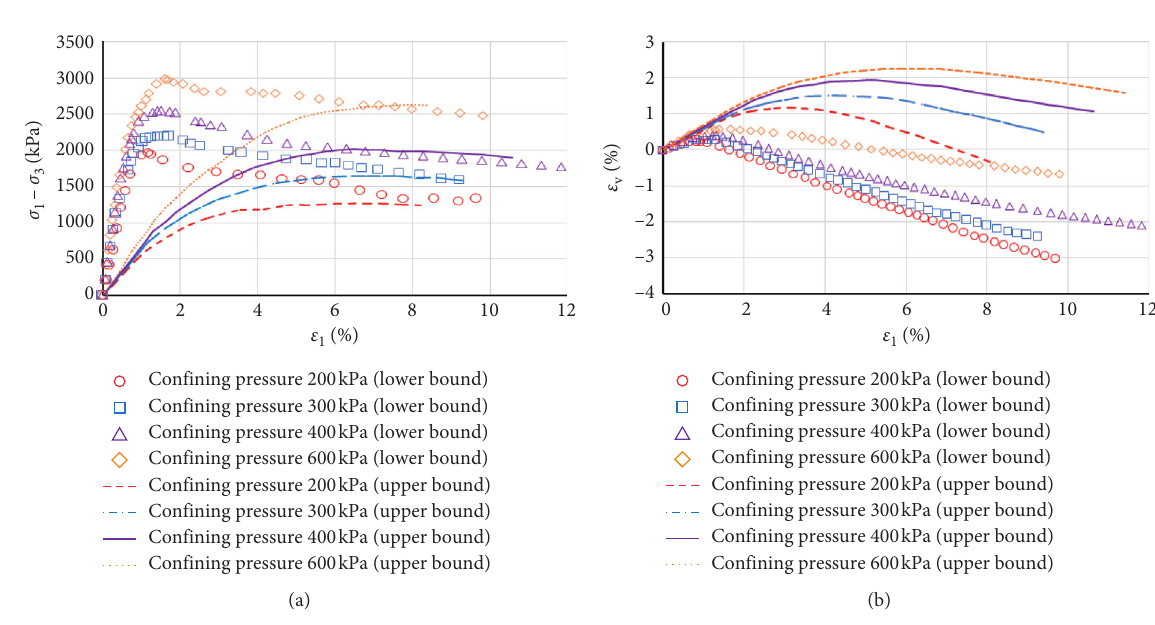
Figure 10: Relationship curves of the deviatoric stress and body strain with the axial strain of rockfill materials with gradation at the upper and lower bound of the gradation envelope after grouting reinforcement. (a) Deviatoric stress for the upper bound and lower bound. (b) Body strain for upper bound and lower bound. Table 3: Strength parameters and Duncan-Chang model parameters of rockfill materials at different gradation levels after